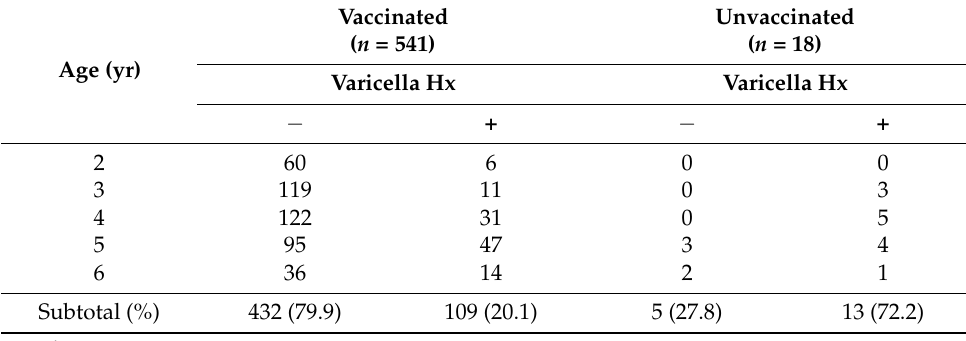
Table 1. Characteristics of children enrolled in the cross-sectional study.